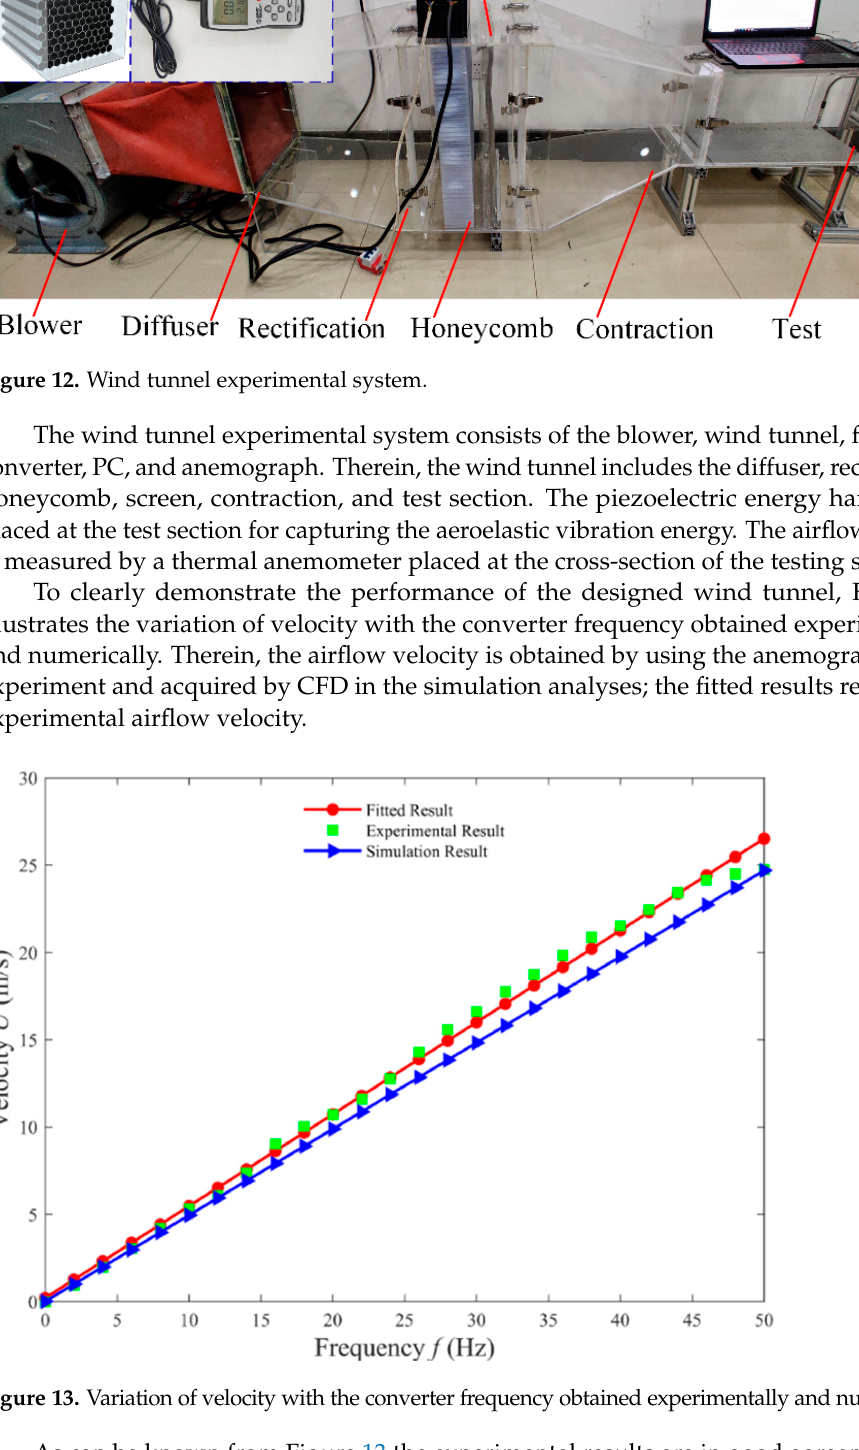
Figure 12. Wind tunnel experimental system.